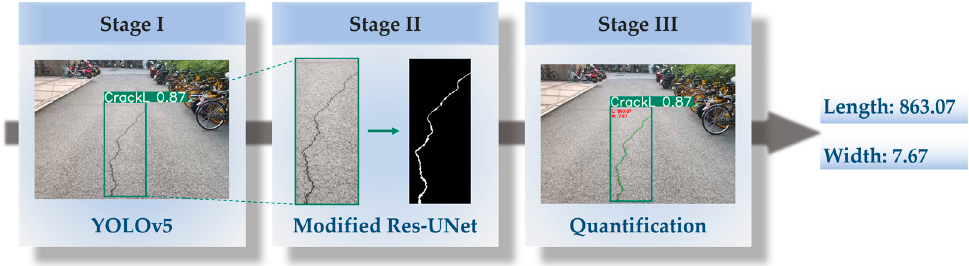
Figure 1. Flowchart of the proposed architecture for detecting and quantifying road cracks.